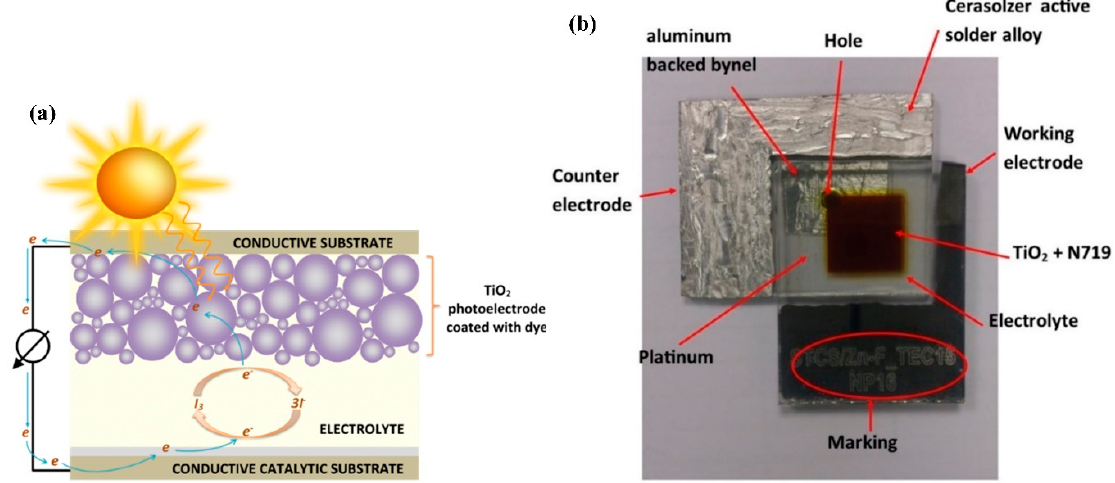
Figure 2. ( a ) The schematic diagram and ( b ) optical images of an assembled dye-sensitized solar cell (DSSC).